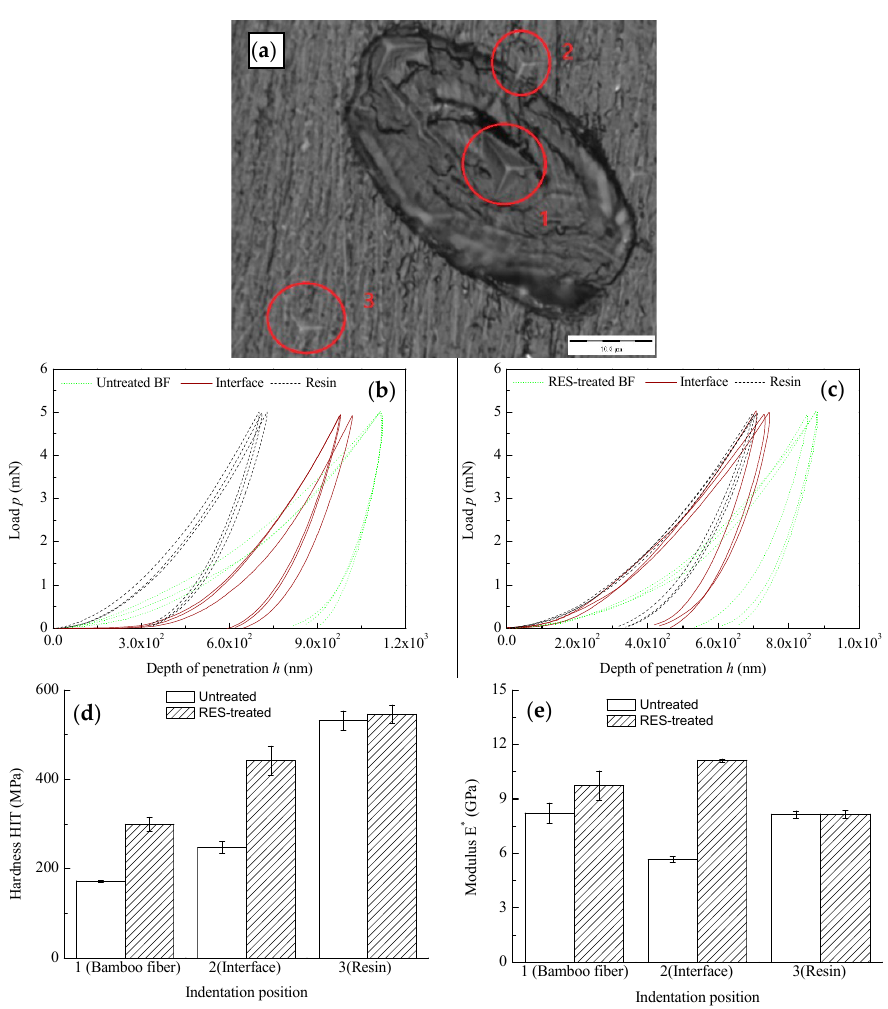
Figure 6. Indentation hardness and elastic modulus of each test point in the interface zone between fiber and resin: ( a ) The selection of indentation test position; ( b ) load-displacement curves of untreated composites; ( c ) load-displacement curves of RES-treated composites; ( d ) indentation hardness of composites; ( e ) indentation elastic modulus of composites.